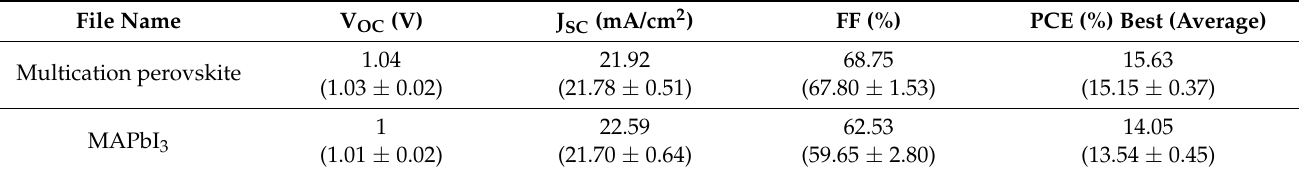
Table 2. The best (average) photovoltaic parameters of optimized PSCs.